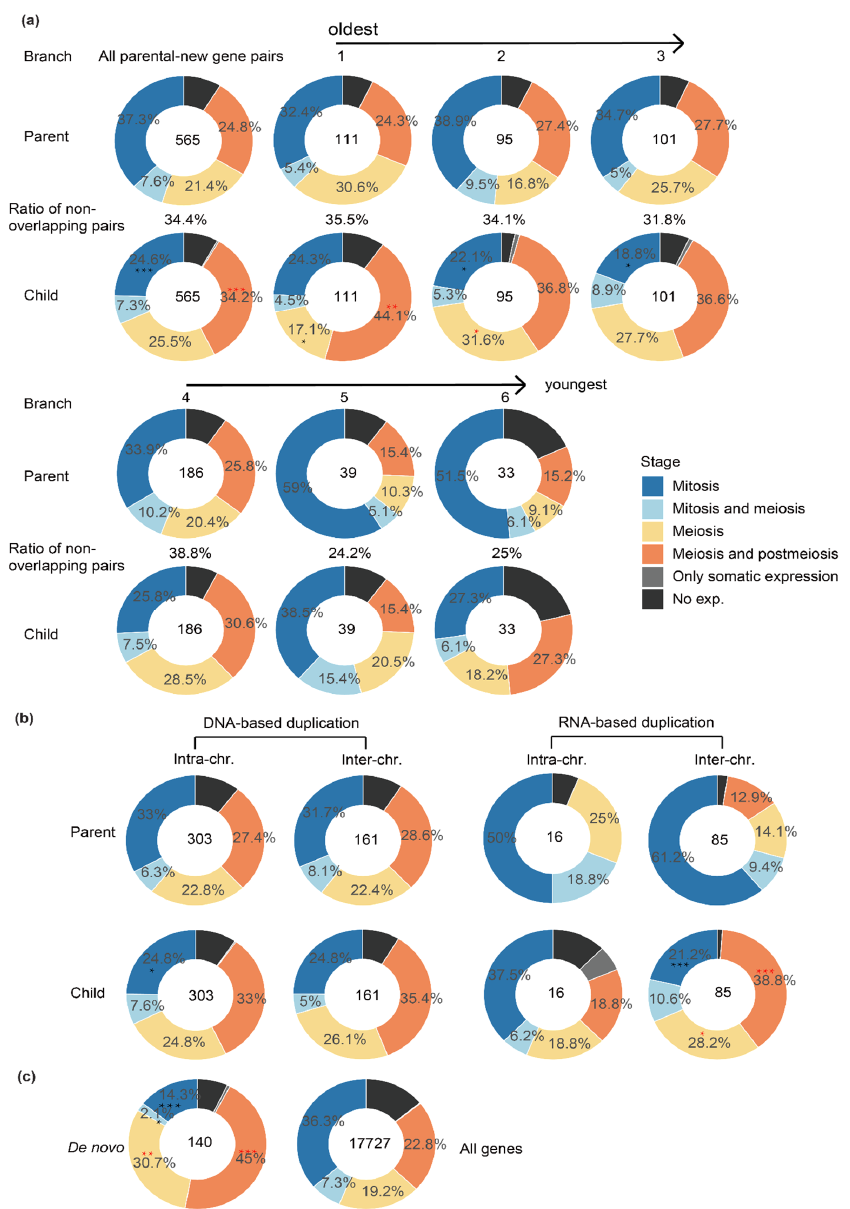
Figure 2. The expression patterns of parental–new gene pairs across testis cells divided by their age and origination mechanisms. ( a ) Comparing parental (‘Parent’) and new (‘Child’) genes of different age groups (1–6, Figure 1a) for their expression patterns within different cell types. Different colors represent different categories of genes inferred from Figure 1b. The numbers within each ring shows the number of parental–new gene pairs of each age group. Additionally, the percentage number shown between the rings of parental genes and new genes indicates the percentage of genes that are expressed in completely non-overlapping cell types of testes. ( b ) Comparison between DNA-based (‘DNA’) and RNA-based (‘RNA’) gene duplications and also between intra- or inter-chromosomal duplications. ( c ) Comparison between the de novo genes and the genomic background of all genes (Flybase 6.15 released version). The significant tests were performed by Fisher test for ( a , b ), between each parental and new gene set. Red asterisks mean significantly enriched; black asterisks mean significantly underrepresented. “*”: p < 0.05, “**”: p < 0.01, “***” p <